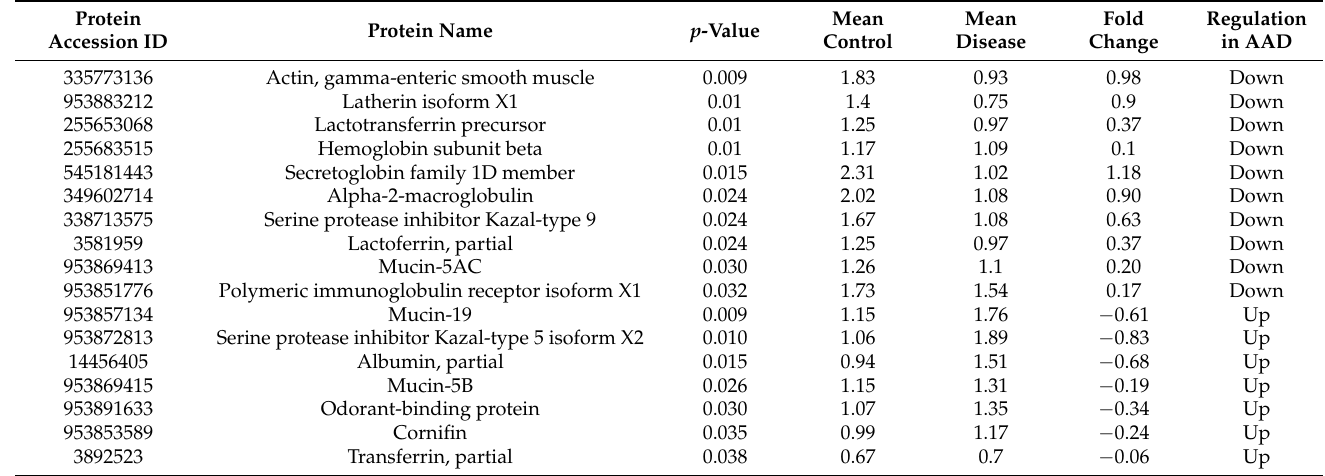
Table 1. Statistically significant expression changes of proteins in horses’ saliva with acute abdominal disease ( n = 7) in relation to healthy horses ( n = 6).